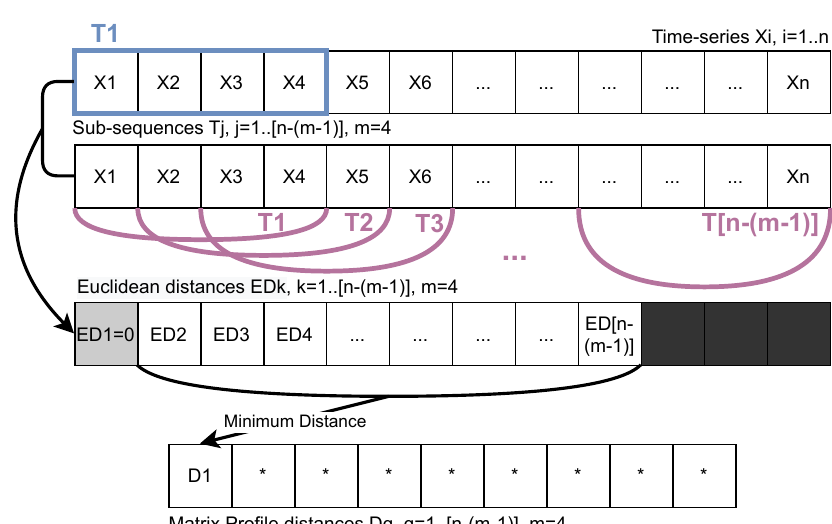
Matrix Profile distances Dq, q=1..[n-(m-1)], Figure 2. Diagram of the Matrix Profile technique